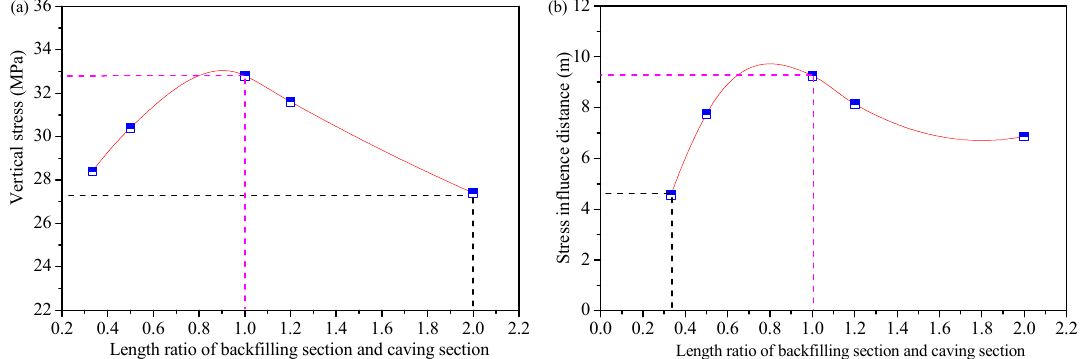
Figure 7. Stress and its influence area in transition section: ( a ) Vertical stress ( b ) stress influence area.